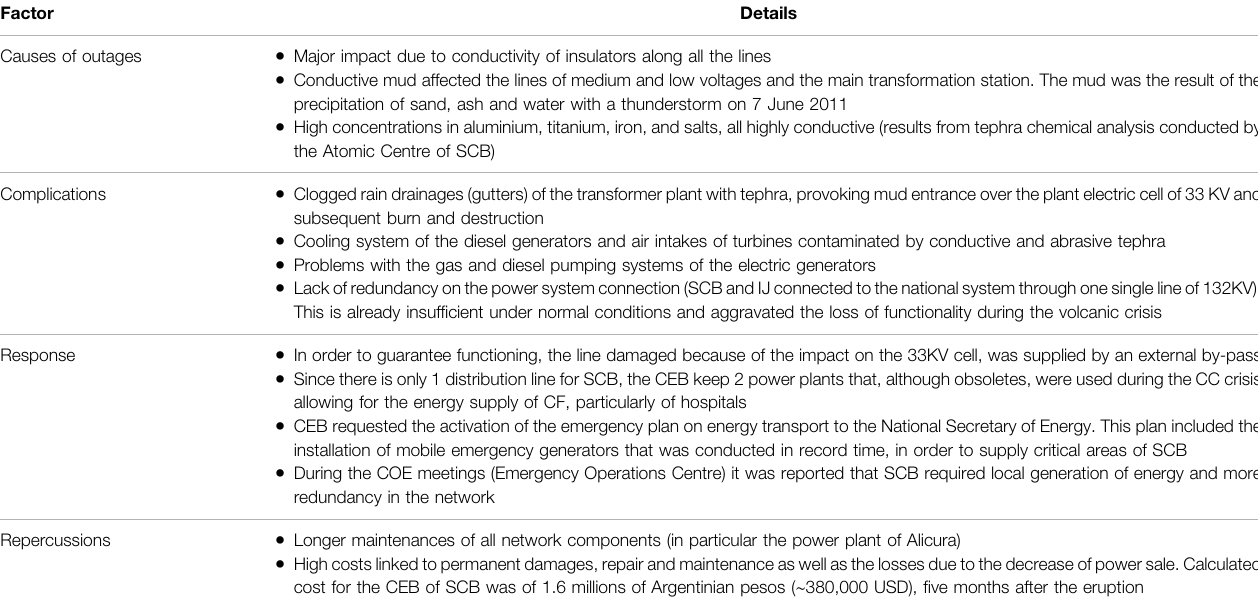
TABLE 5 | Integrative impact assessment – Step II: fi nding evidences of impacts and aggravating factors on the power system of SCB. Data compiled from interviews and technical reports of the CEB. Factor